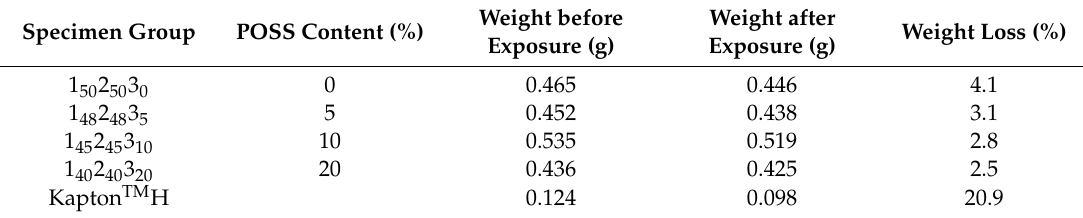
Table 6. Mass loss analysis of samples with di ff erent POSS content and di ff erent curing procedures for 12 months in simulated low Earth orbit (LEO) conditions. Specimen Group POSS Content (%)